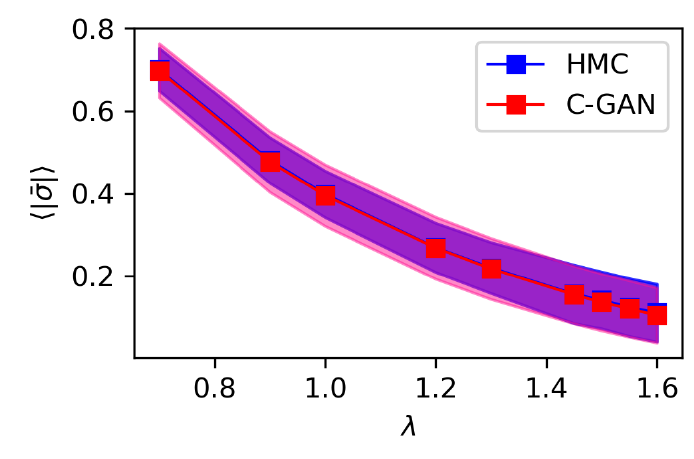
Figure 13: Mean 〈| ¯ σ |〉 and standard deviation for Λ ts obtained via HMC and